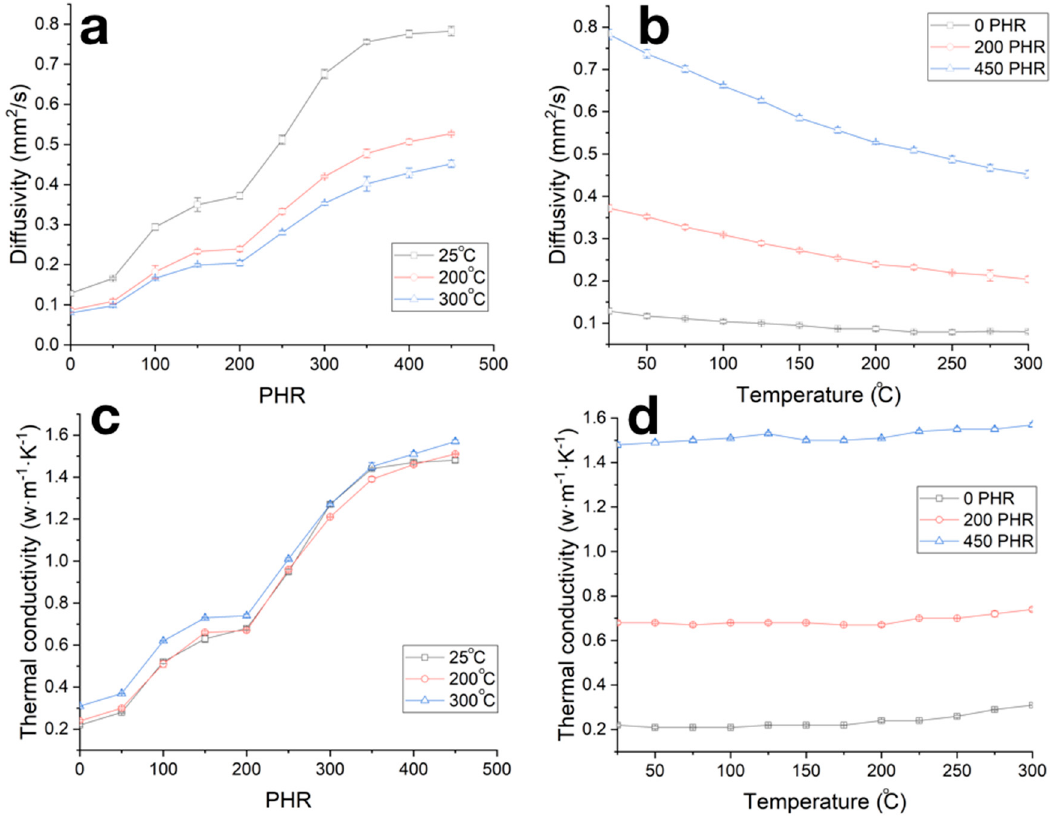
Figure 10. Dependencies of thermal diffusivity ( a , b ) and thermal conductivity coefficient ( c , d ) on the filling degree ( a , c ) and temperature ( b , d ) for carbonized composites.